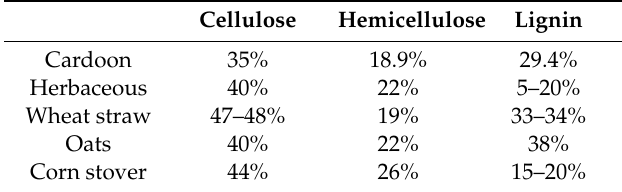
Table 1. Mean composition of main residual cereal material [26].